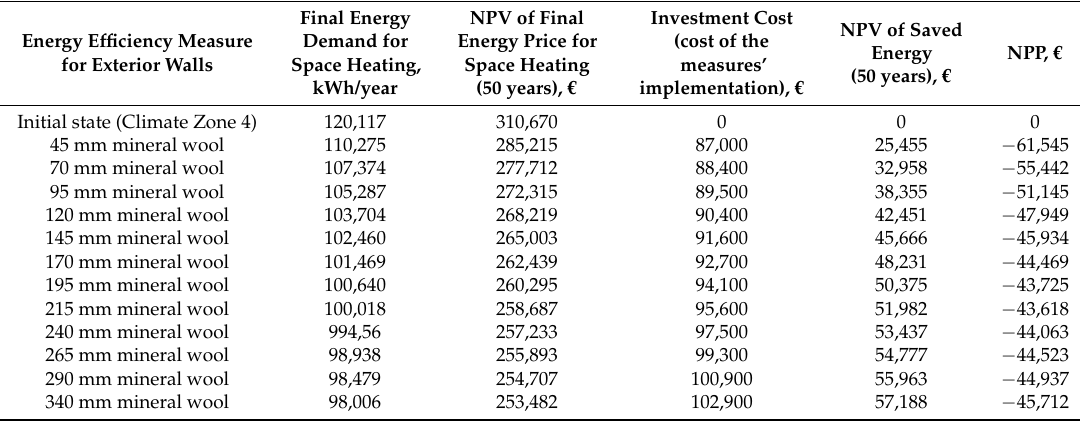
Table 7. Additional insulation materials on exterior walls, assuming a 3% discount rate and a 50 ‐ year lifespan (an example for the calculation